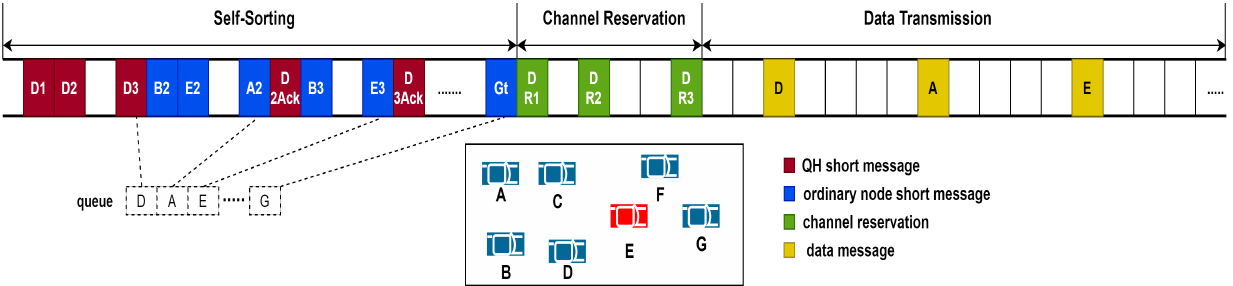
Figure 16. Mechanism of self-sorting